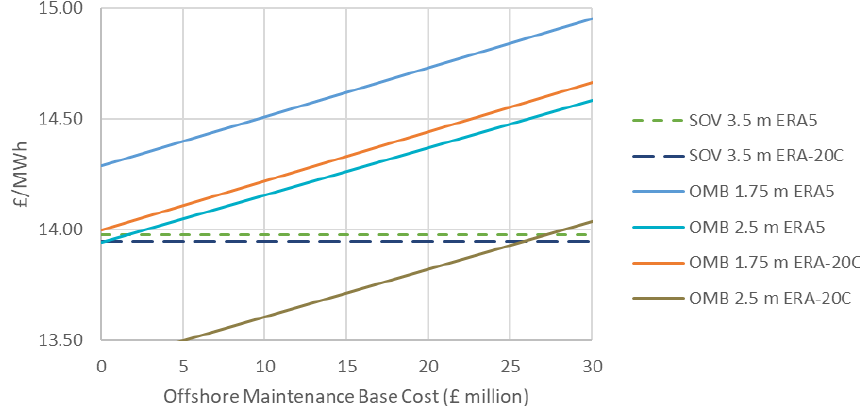
Figure A1. Six scenarios compared with varying the costs associated with the OMB.